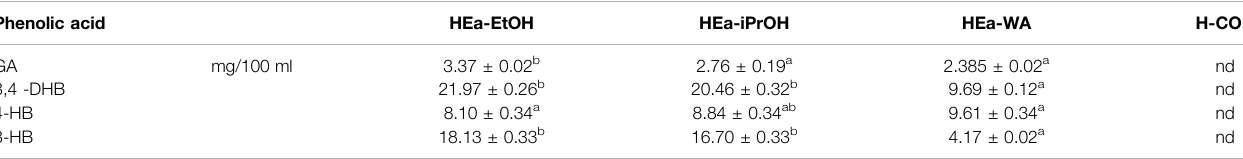
TABLE 2 | Content of selected phenolic acids in HEas. Phenolic acid